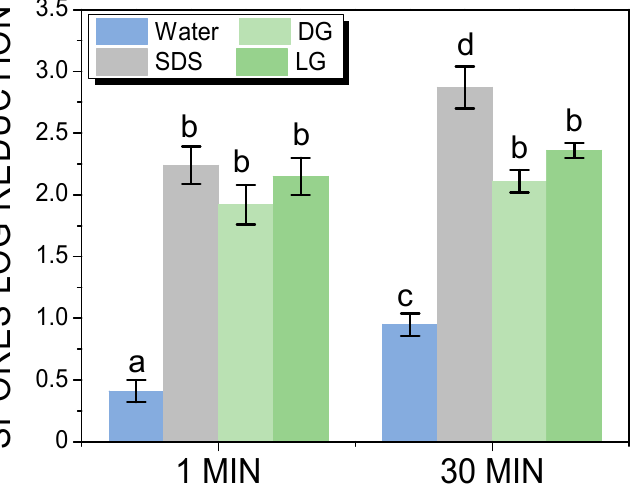
Figure 2. Spores log reduction on the plate in dynamic condition during foam flow cleaning after 1 and 30 min of foam flow as a function of the surfactant in comparison to water. The small letters a–d indicate groups of statistical differences according to Tukey’s test ( p < 0.05) between the water and the surfactants for 1 min of foam flow cleaning and for 30 min of foam flow cleaning.